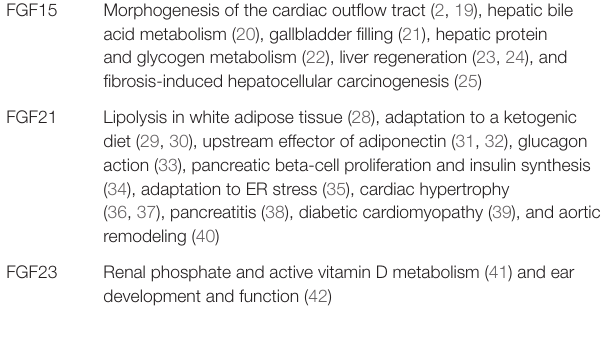
TABLe 1 | Roles of endocrine FGFs indicated by their knockout mouse phenotypes.